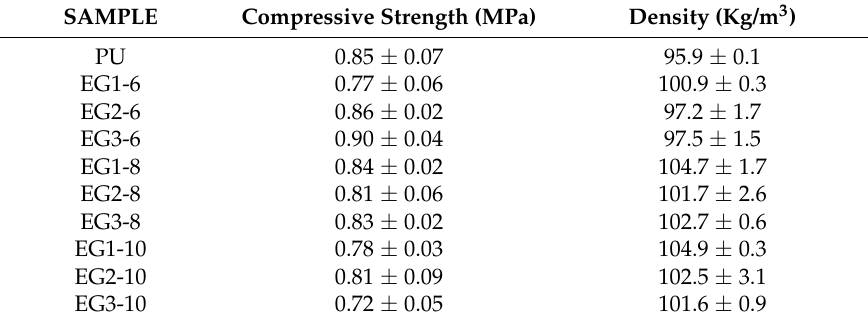
Table 6. Mechanical data of EG/RPUF